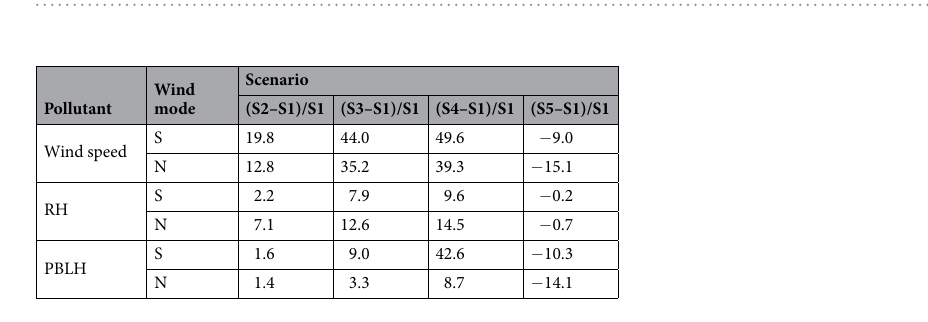
Table 4. Percentage changes (%) in the meteorological variables among the different scenarios and the different wind